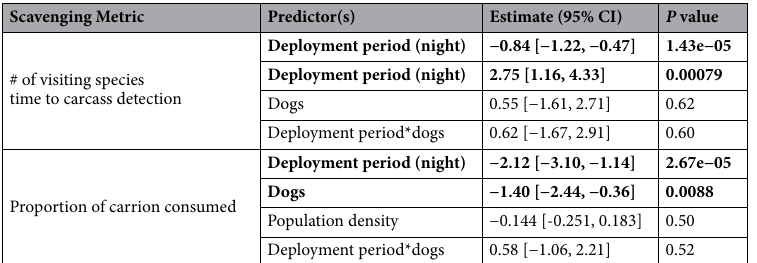
Scavenging Metric Predictor(s) Estimate (95%